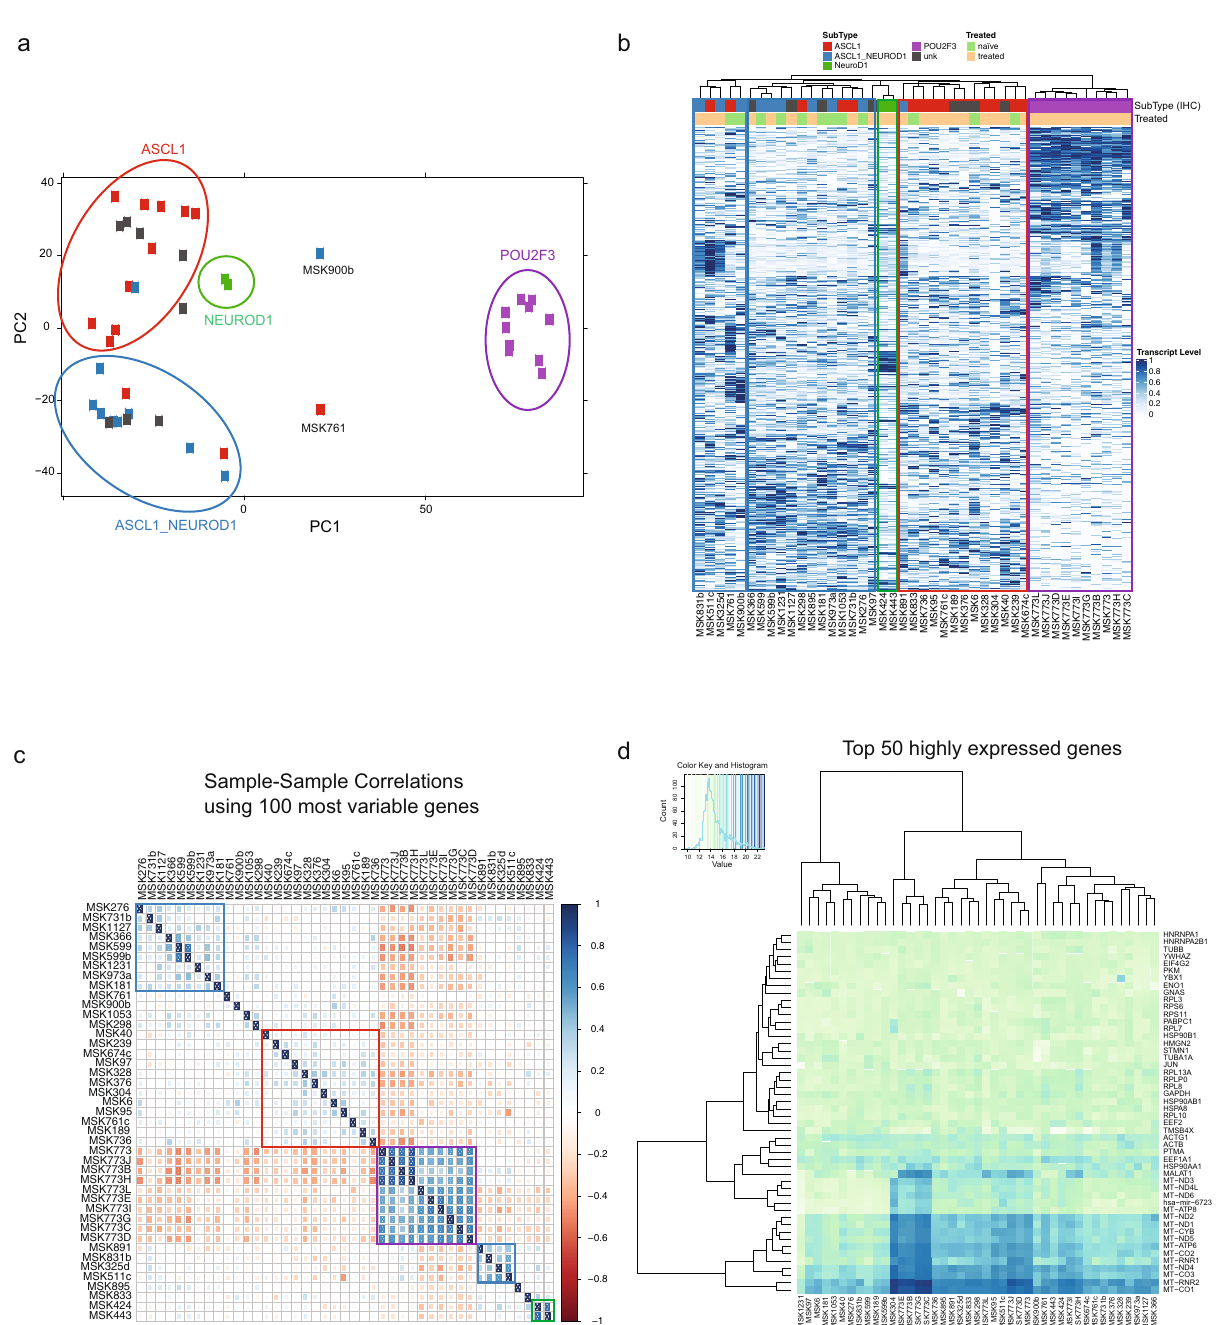
Fig. 4 Transcriptional pro fi le analysis of SCLC tumors of different subtypes. a Principal component analysis plot showing 43 patient-derived xenograft (PDX) samples color-coded based on immunohistochemistry (IHC) subtype annotation. Circles indicate four separate clusters ( ASCL1 -driven cluster, red; ASCL1/NEUROD1 -driven cluster, blue; NEUROD1 -driven cluster, green; POU2F3 -driven cluster, purple). Source data are provided as a Source Data fi le. b Unbiased hierarchical clustering of 43 PDX samples. Color-coded panel on top depicts treatment status (naïve or treated) and subtype annotation based on IHC. Boxes indicate fi ve separate clusters (two ASCL1/NEUROD1 -driven clusters, blue; one NEUROD1 -driven cluster, green; one ASCL1 -driven cluster, red; one POU2F3 -driven cluster, purple). Source data are provided as a Source Data fi le. c Sample-sample correlation plot using the top 100 highest variance genes. The Spearman correlation was used and the samples were ordered using hierarchical clustering with complete linkage. Five clusters emerged and are boxed (two ASCL1/NEUROD1 -driven clusters, blue; one NEUROD1 -driven cluster, green; one ASCL1 -driven cluster, red; one POU2F3 -driven cluster, purple). Source data are provided as a Source Data fi le. d Heatmap of the top 50 highly expressed genes in 43 PDX samples. Blue indicates high expression and green indicates low expression. Color key and histogram represents the normalized log 2-transformed counts. Source data are provided as a Source Data fi